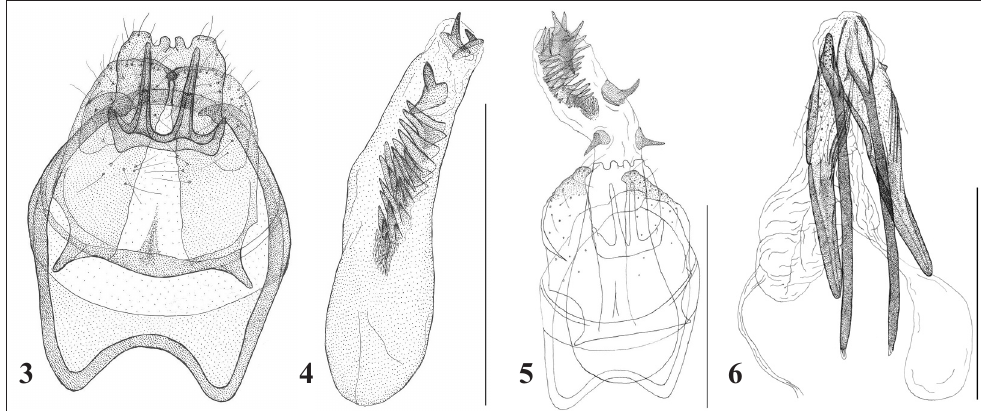
Figures 3–6. Male and female genitalia of Stigmella tatrica sp. n., paratypes. 3. Male genitalia, Gp. ZT ♂ 9085, dorsal view; 4. phallus; 5. Gp. ZT ♂ 9087, vesica everted. 6. Female genitalia, Gp. ZT ♀ 12876.